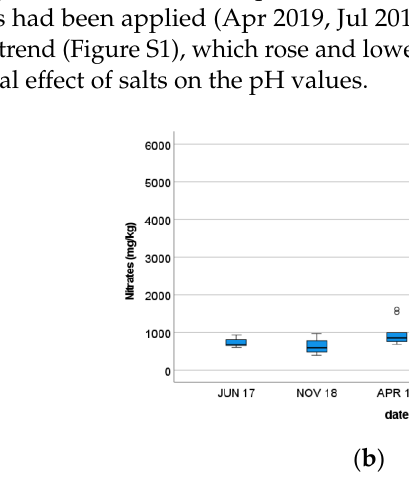
Figure 1. Soil EC and nitrates (mean of the whole experimental field) evolution over time, including the pre- and post-manure additions, and once irrigation treatments had been applied (( a ), EC; ( b ), nitrates).